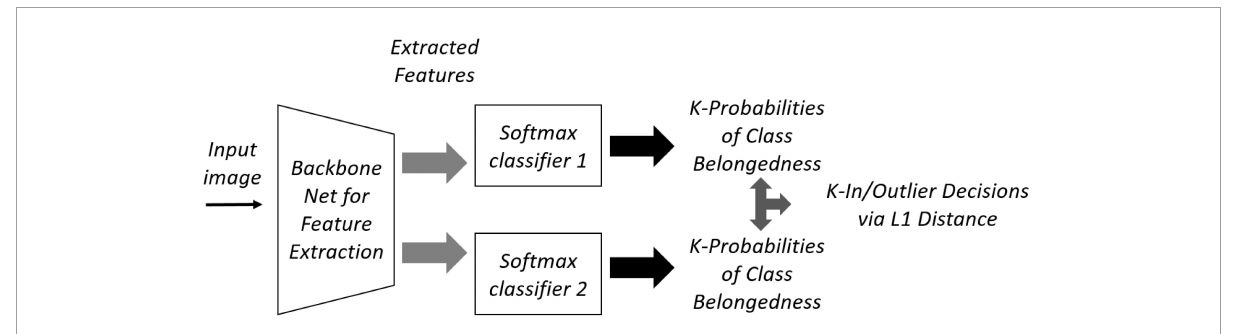
FIGURE2 Prototypical images of known diseases and unknown diseases.